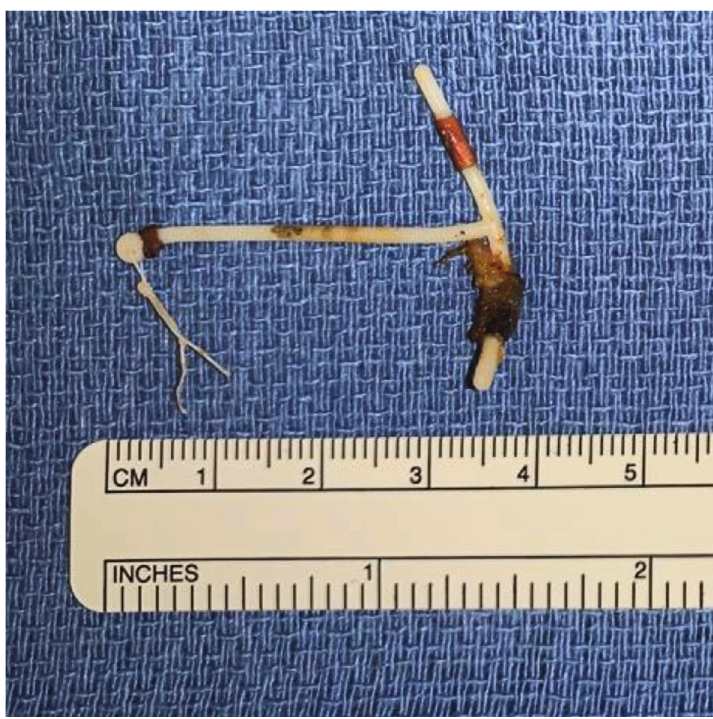
Figure 3: IUD specimen following surgical removal from the